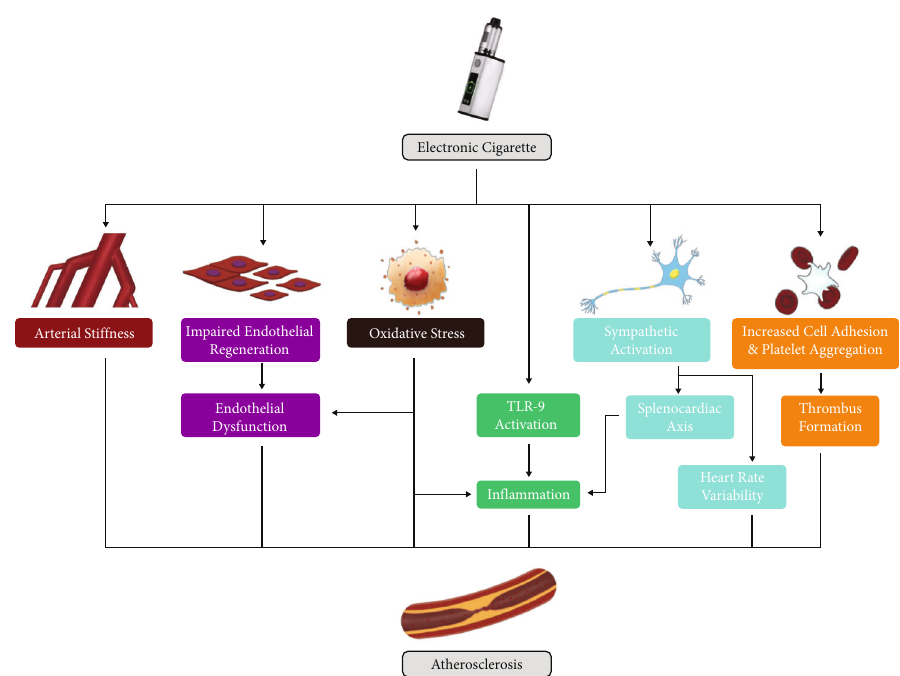
Figure 3: Mechanisms by which e-cigarette contributes to the pathogenesis of